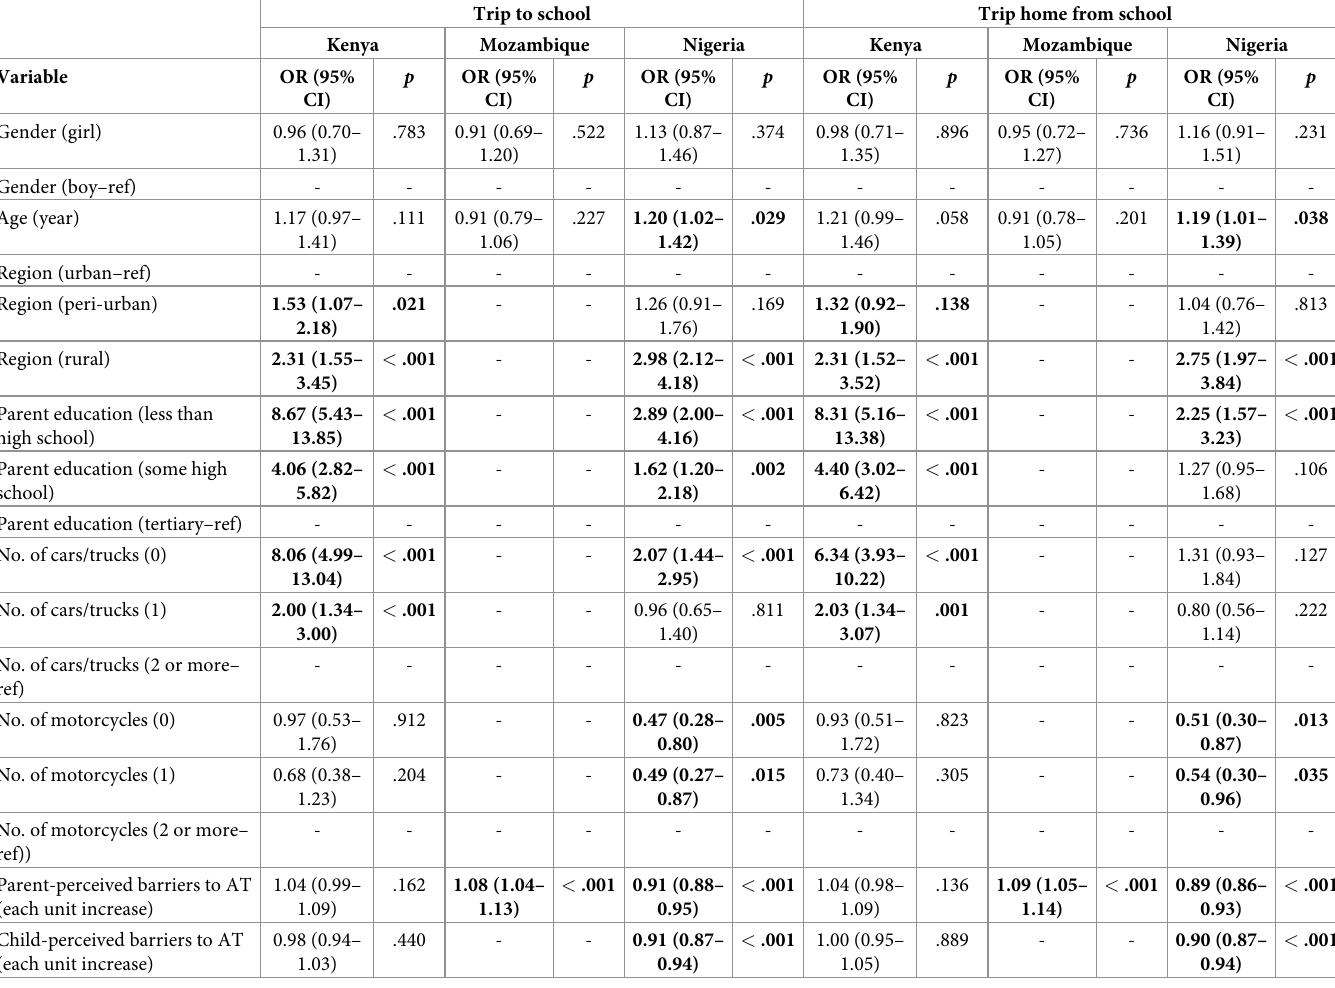
Table 3. Results of bivariate models examining the correlates of AT for the trip to school and home from school. Trip to